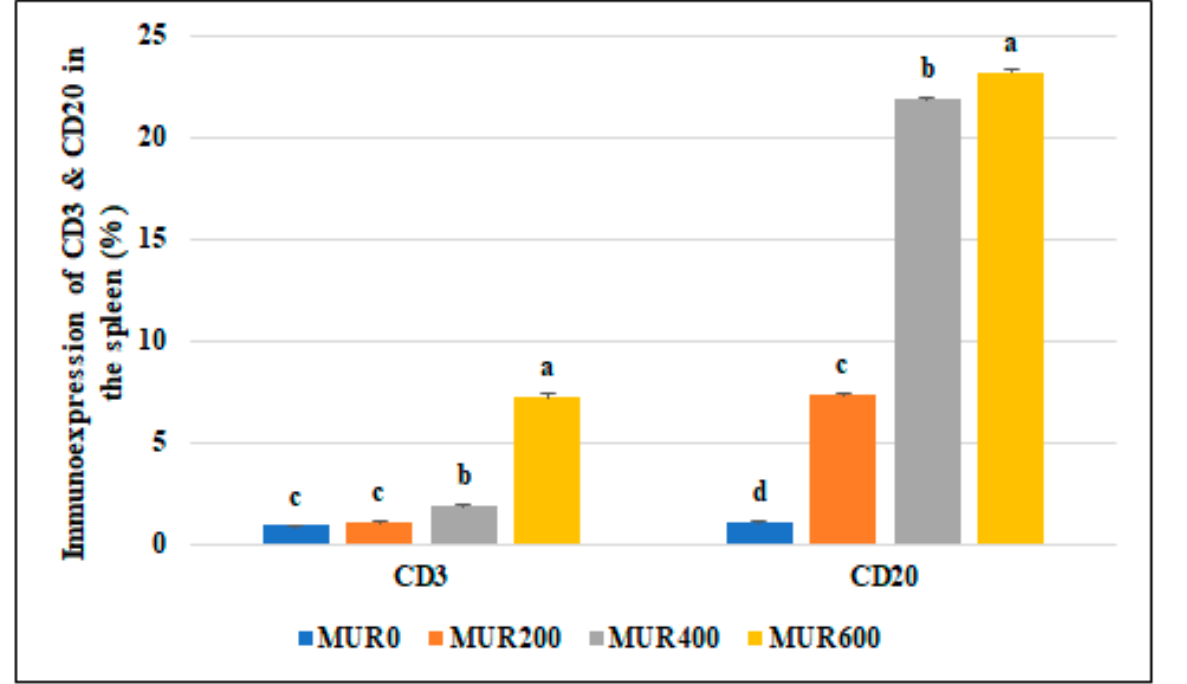
Figure 3. The morphometric analytic data of immunostained CD3 and CD20 cells in the spleen of different experimental groups. Means with different superscripts ( a, b, c, d ) are significantly different at p < 0.05.